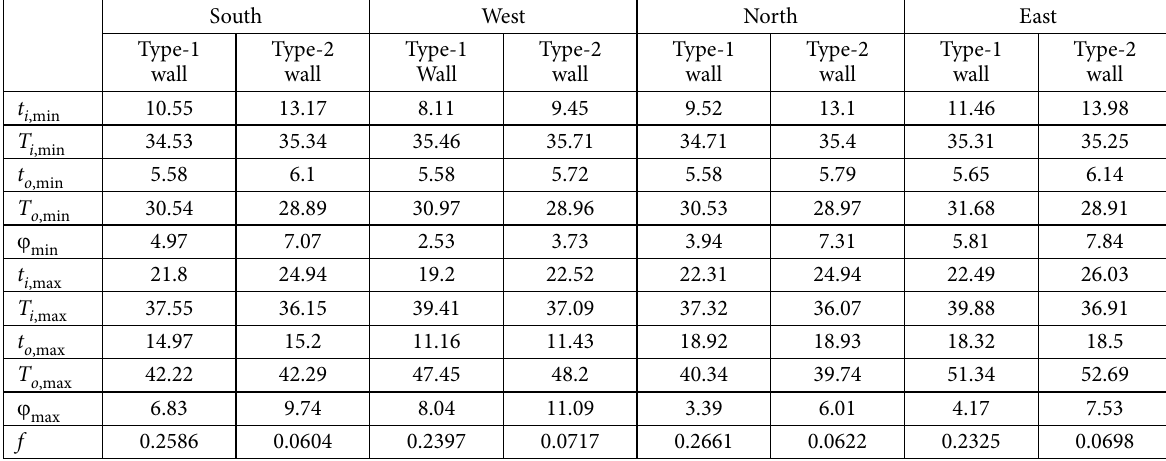
Table 7. Values of time lag, decrement factor and corresponding temperatures for type-1 and type-2